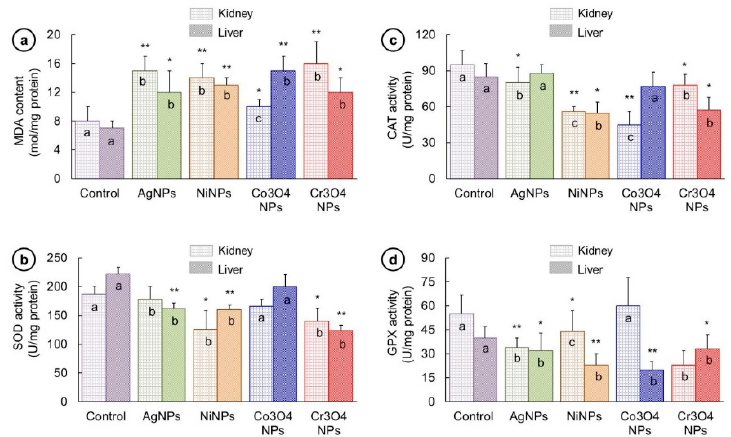
Figure 9. ( a ) Malondialdehyde (MDA) was observed to be significantly high in kidney and liver of all NP-treated groups ( b ) Superoxide dismutase (SOD) activity was significantly low in kidney of NiNP- and Cr 3 O 4 NP-treated groups and liver of AgNP-, NiNP-, and Cr 3 O 4 NP-treated groups. ( c ) Catalase (CAT) activity was significantly low in NiNP- and Cr 3 O 4 NP-treated kidney and NiNP- and Cr 3 O 4 NP-treated liver. ( d ) Glutathione peroxidase (GPx) activity was significantly low in AgNP-, NiNP-, and Cr 3 O 4 NP-treated kidney and the liver of all treated groups. Columns showing different letters (a, b, and c) are significantly different. (* p < 0.05) (** p < 0.01).